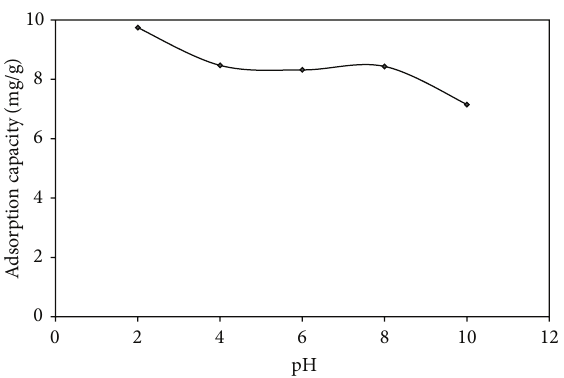
Figure 7: Langmuir adsorption isotherm for RhB onto NSCSH.